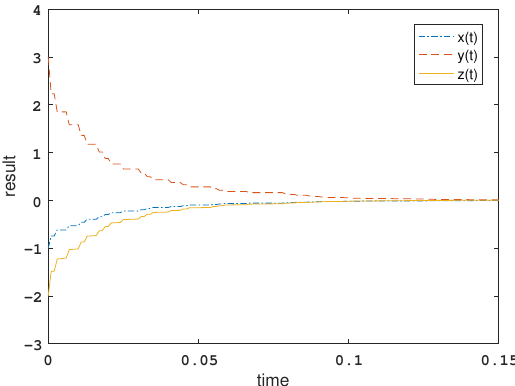
Figure 9. Rössler’s System after control at α =